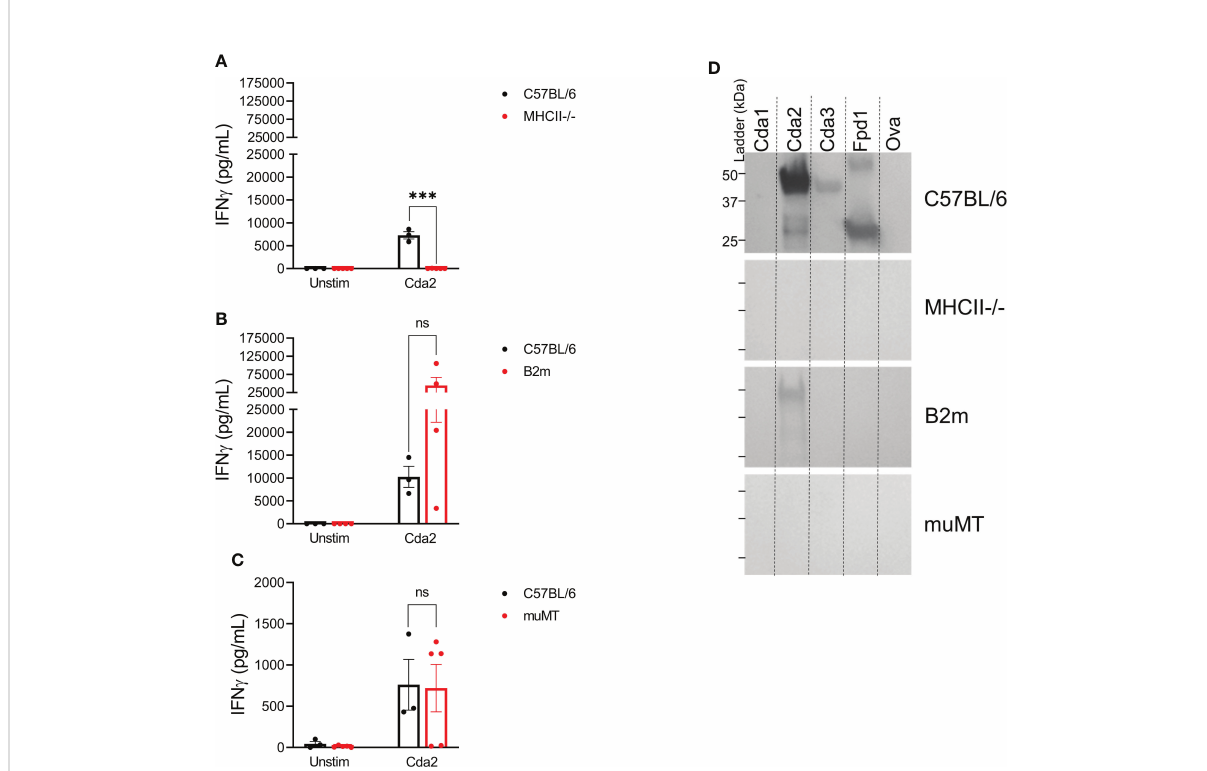
FIGURE 4 Loss of CD4 + T cells ablates serum IgG and ex vivo IFN g production in the splenocytes of GP-Cda2 vaccinated mice. Mice were vaccinated as in Figure 2. Two weeks after the third vaccination, the mice were euthanized and spleens and serum were collected for analysis as in Figure 3 and Figure 2, respectively. (A – C) IFN g production by the splenocytes of GP-Cda2 vaccinated mice following ex vivo stimulation. Error bars represent the standard error of the mean, with each sample graphed as the average of 2 technical replicates. Signi fi cance was determined by ordinary one-way ANOVA with Welch ’ s correction. ns, not signi fi cant; or *** signi fi cant at P ≤ 0.0001. (A) n=3 mice for C57BL/6 and n=5 mice for the MHCII-/-. (B) n=3 mice for C57BL/6 and n=4 for B2m. (C) Due to the small size of spleens from muMT mice, only 2.5x10 5 splenocytes were stimulated per well. C57BL/6 n=3 and muMT n=5. (D) Western blots for IgG response in the pooled serum of GP-Cda2 vaccinated mice. Molecular masses of the protein standards are denoted by the ticks on the left such that the top, middle, and bottom ticks for each blot are 50 kDa, 37 kDa, and 25 kDa, respectively. The Western blots have been cropped to show the relevant portions but not spliced or digitally